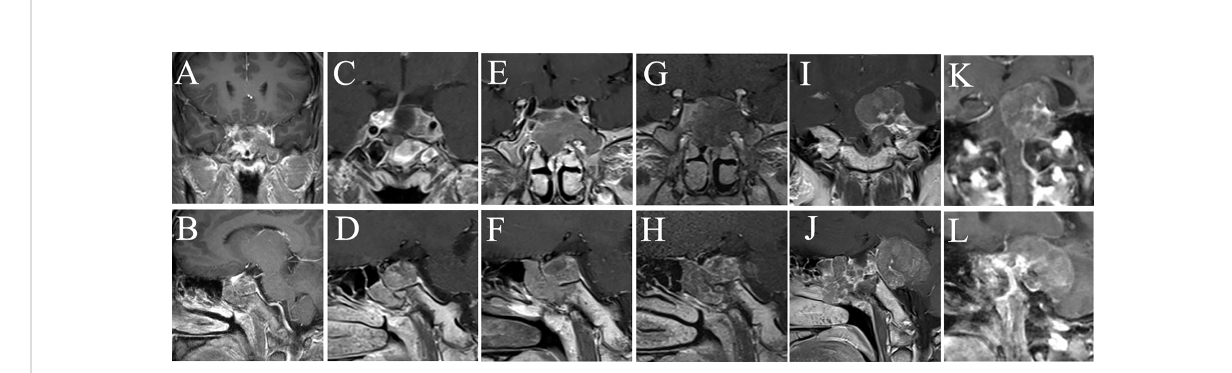
FIGURE 2 MRI examination of case 1. The images show the patient ’ s coronal and sagittal MRI of the head before (A, B) , one week after (C, D) , six months after (E, F) , eight months after (G, H) , sixteen months after (I, J) , and seventeen months after (K, L) the fourth surgery, respectively.